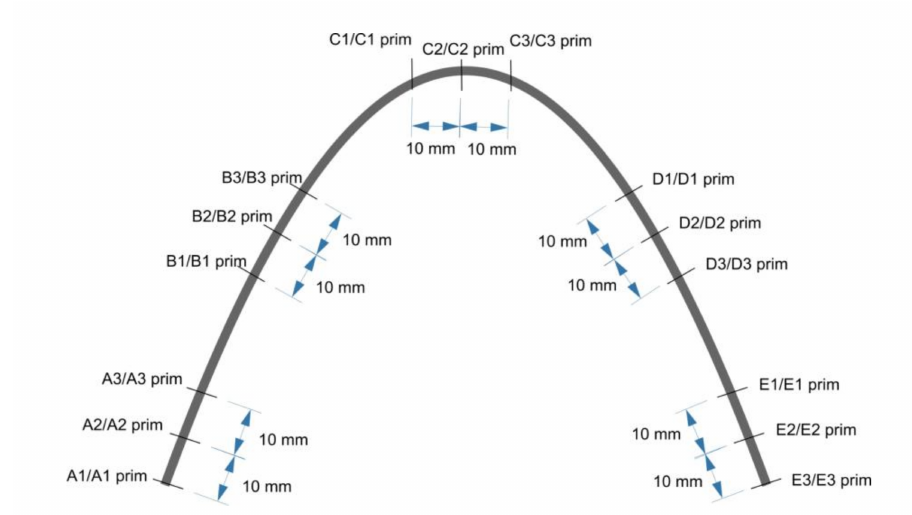
Figure 1. Locations of measurement points (prim—same location on the second side of